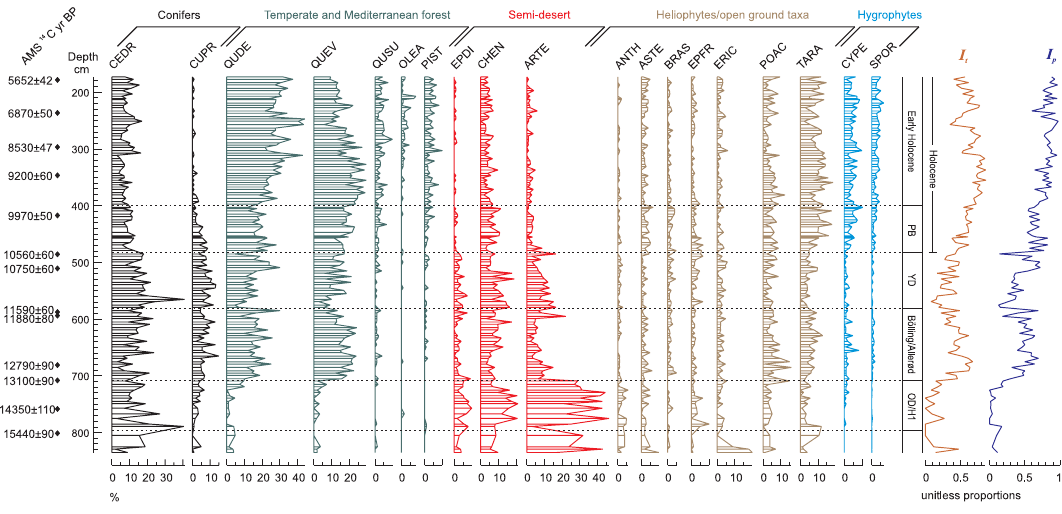
Fig. 4. Pollen percentage data plotted against depth from core MD95-2043 for major taxa Cedrus (CEDR), Cupressaceae (CUPR), Quer- cus deciduous type (QUDE), Quercus evergreen type (QUEV), Olea (OLEA), Pistacia (PIST), Ephedra distachya type (EPDI), Chenopo- diaceae (CHEN), Artemisia (ARTE), Anthemis type (ANTH), Aster type (ASTE), Brassicaceae (BRAS), Ephedra fragilis type (EPFR), Ericaceae (ERIC), Poaceae (POAC), Taraxacum (TARA), Cyperaceae (CYPE) and fern spores (SPOR). Pollen data available online at doi:10.1594/PANGAEA.711649. Also shown are the pollen-based indices I t and I p . I t describes the ratio of evergreen Quercus to conifers ( Cedrus and Cupressaceae); I p describes the ratio of deciduous Quercus to semi-desert taxa. In light of the modern distribution of these taxa with respect to regional climatic gradients (Fig. 2), I t and I p should primarily reflect temperature and precipitation variability,